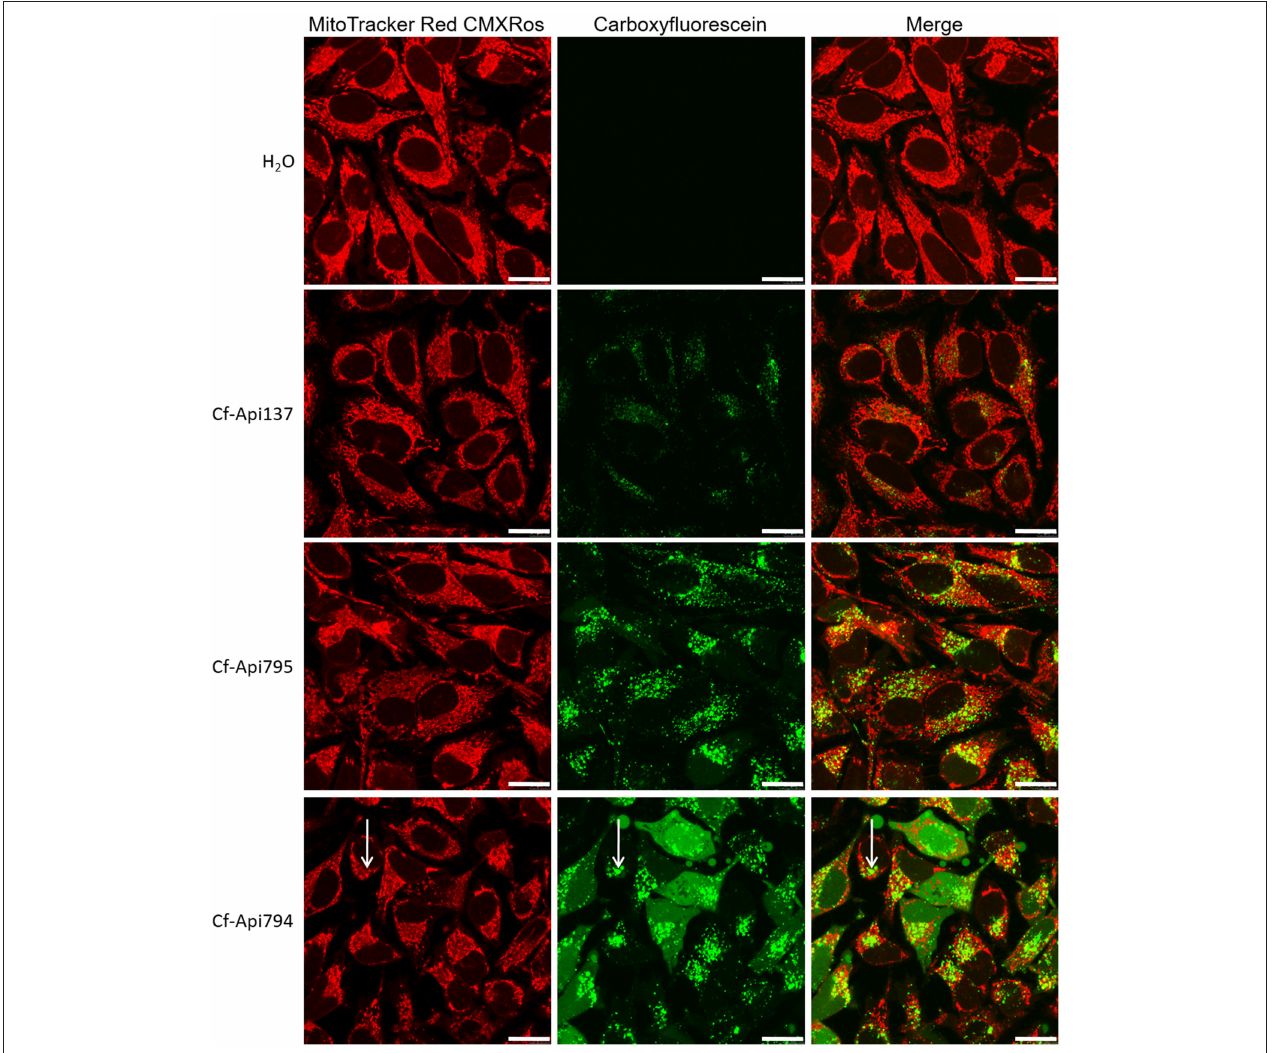
FIGURE 8 | Localization of the peptides in HeLa cells determined by confocal microscopy. Cells were incubated with the indicated peptide (40 µ mol/L) and MitoTracker Red CMXRos (0.1 µ mol/L) for 6 h. Bars refer to 20 µ m. Arrows mark the slight background fluorescence of the mitochondrial stain and the high fluorescence of the Cf-labeled peptide, which overlap (unspecific